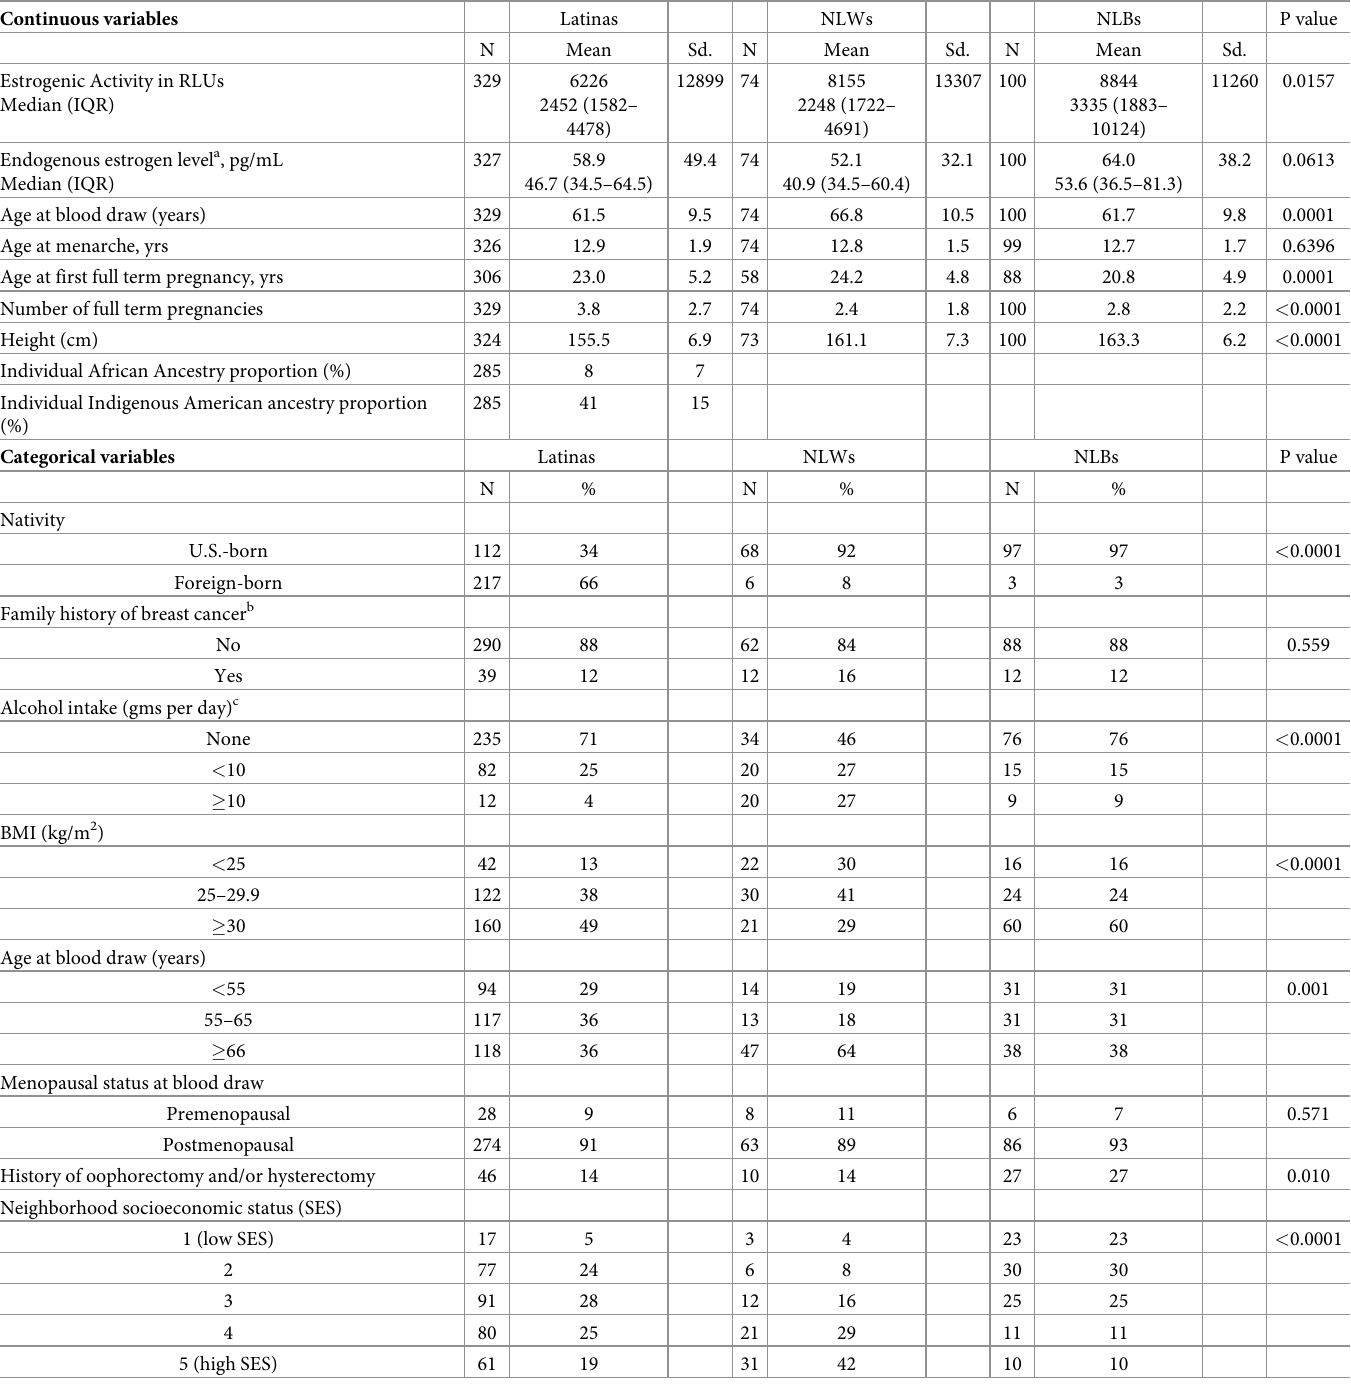
Table 1. Participant characteristics by racial/ethnic group (N =